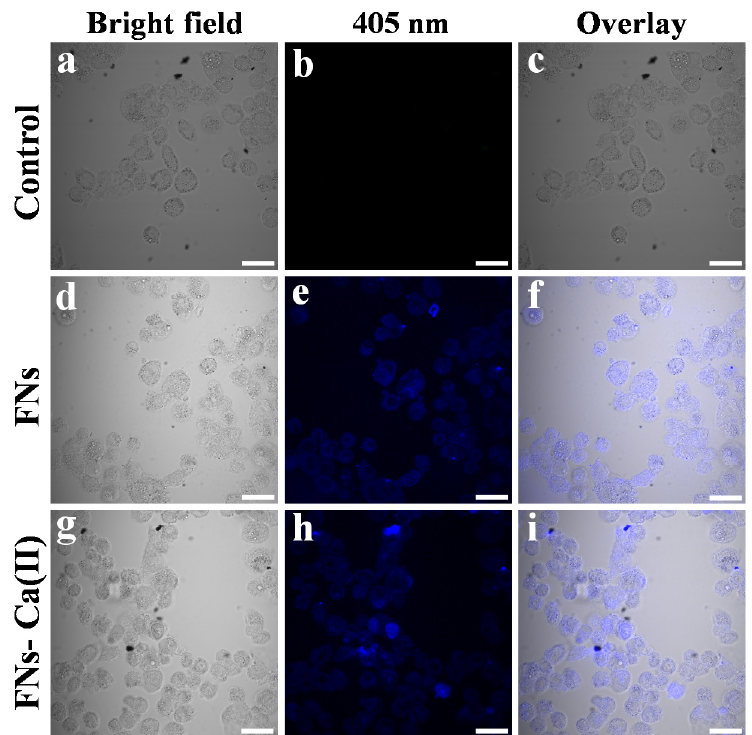
Figure 8. Confocal laser fluorescence images of Caco − 2 cells treated with FNs and FNs − Ca(II) with a 408 nm laser. Bright-field images of Caco − 2 cells ( a , d , g ), fluorescence images of Caco − 2 cells ( b , e , h ), and overlay images of Caco − 2 cells ( c , f , i ). Scale bar representing 30 μ m.